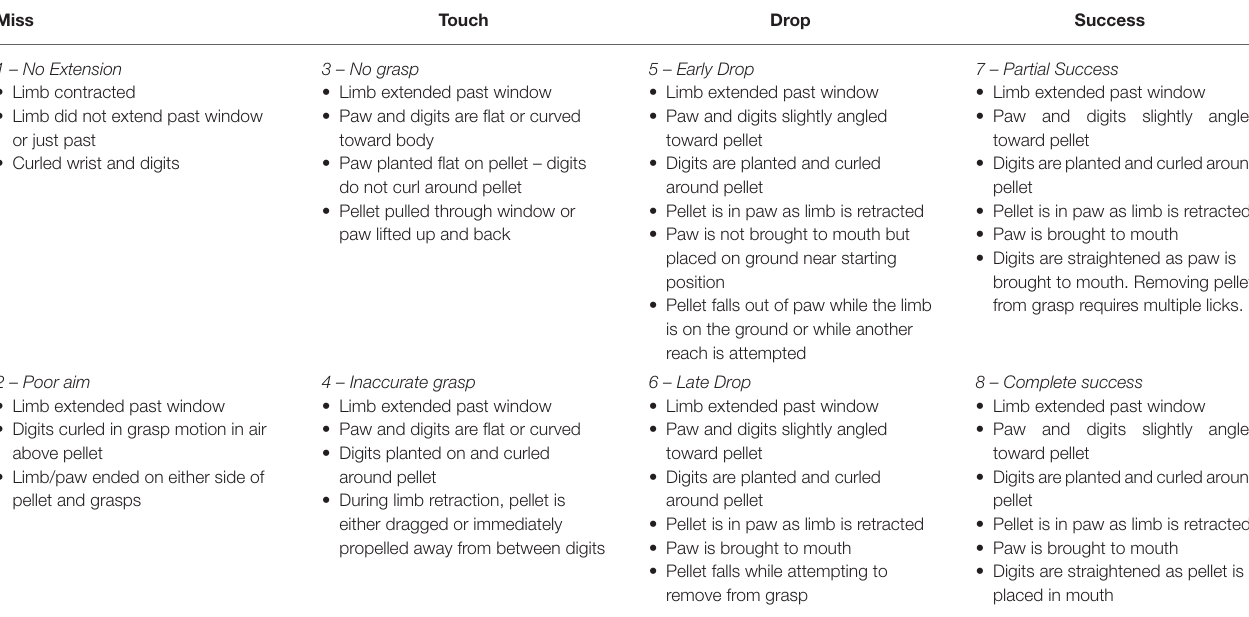
TABLE 1 | Reaching Error